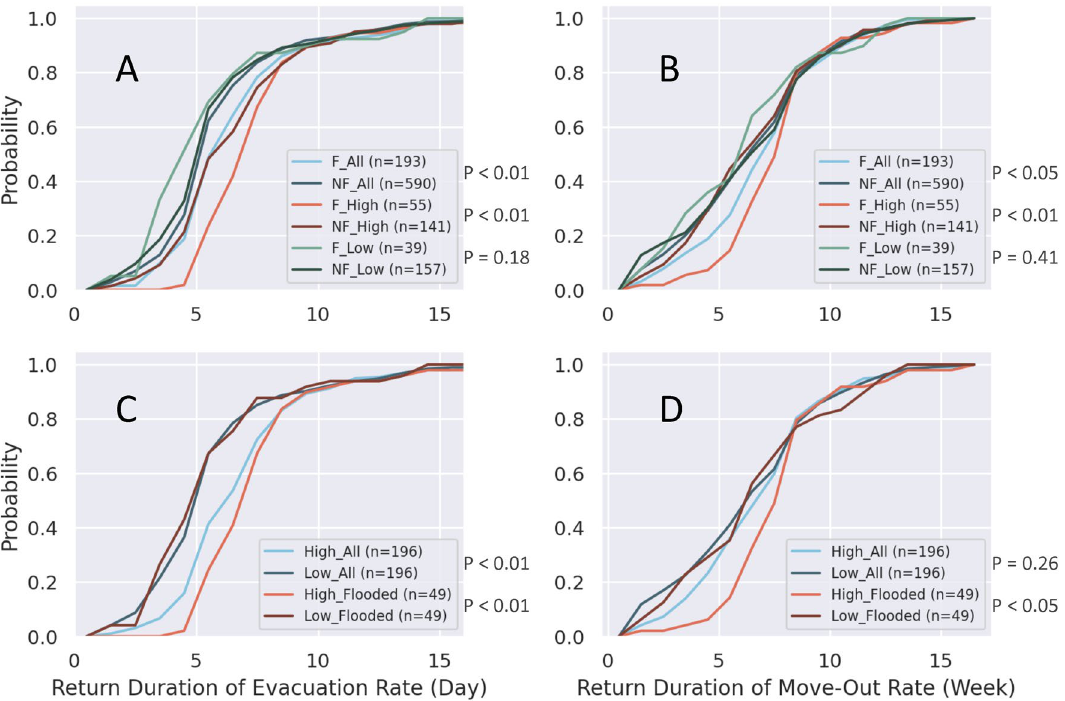
Figure 4. Return patterns of the evacuation and move-out rates for different subpopulations, where the vertical axis is the cumulative probability that represents the cumulative percentage of census tracts returning to a steady state. ( A ) and ( B ) demonstrate the comparison between flooded (F) and non-flooded (NF) areas in all, high-, and low-income populations. ( C ) and ( D ) demonstrate the comparison between high- and low-income populations in all and flooded census